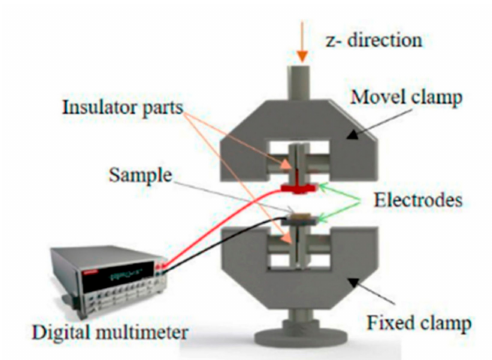
Figure 2. Schematic representation of the experimental configuration of the clamps for the compression experiments with simultaneous electrical measurements for electro-mechanical response evaluation of the